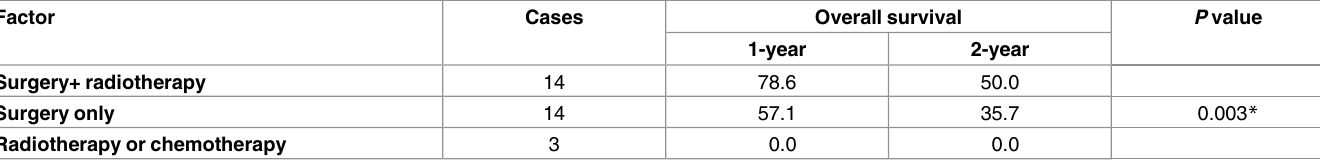
Table 3. The overall survival of different treatment groups of stage IVA and IVB patients.